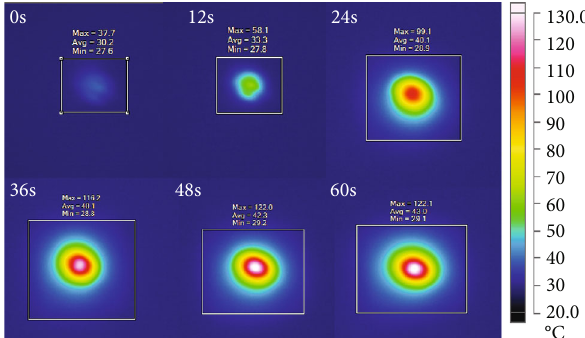
Figure 6: Thermal infrared imaging of C-6